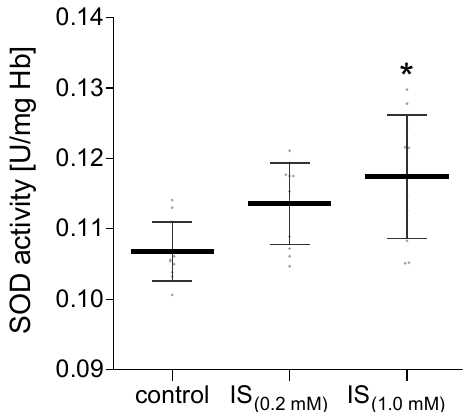
Figure 8. Alterations in the SOD activity in hemolysate after incubation with IS. Data are expressed as mean ± standard deviation, n = 11, * p < 0.05—IS (1.0 mM) vs. control. Gray spots: values of single results.